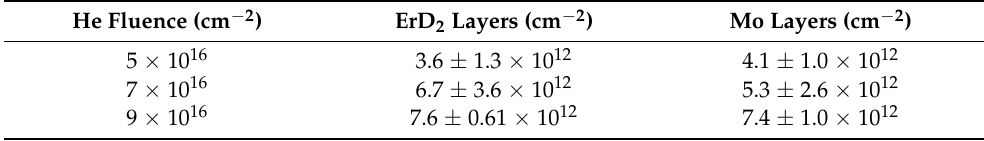
Table 2. He bubble density measured during in-situ He implantation, as a function of fluence. He Fluence (cm − 2